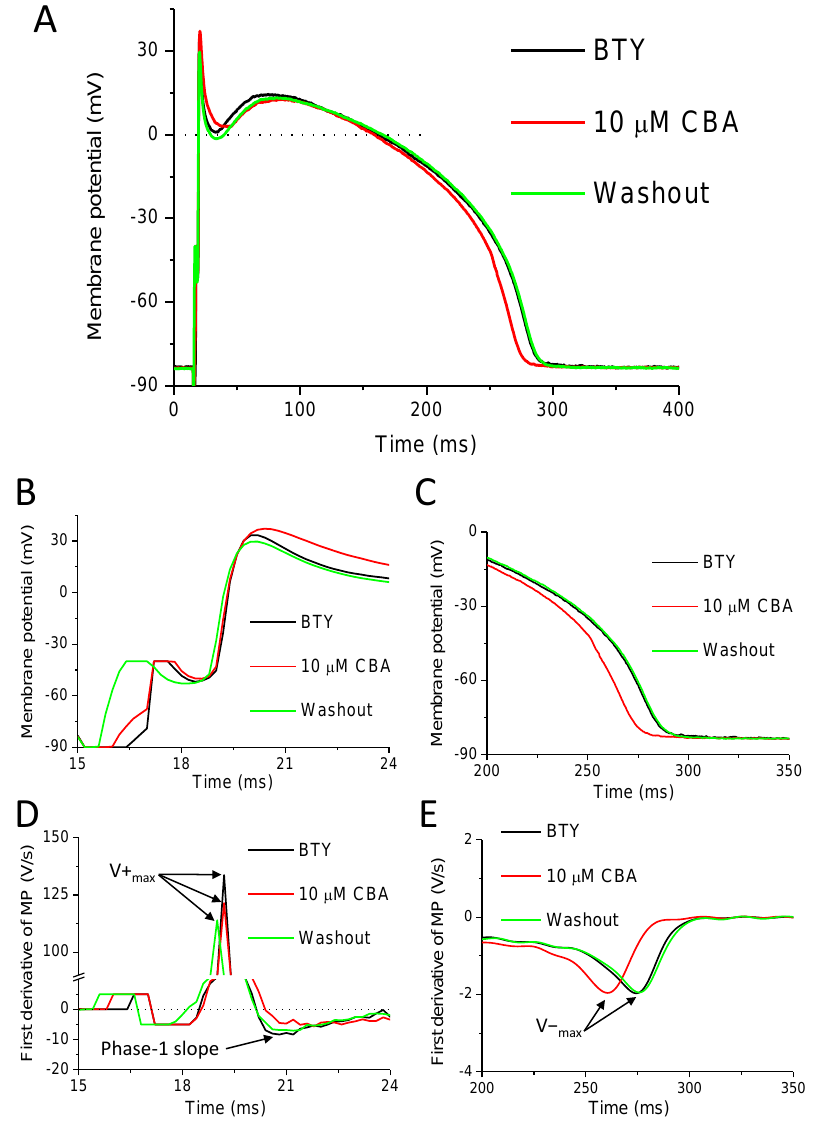
Figure 2. Effect of CBA on action potentials (APs) of canine left ventricular cells. ( A ) Representative APs recorded in control conditions (black), in the presence of the TRPM4 inhibitor (4-chloro-2-(2-chlorophenoxy)acetamido)benzoic acid (CBA), (10 µ M) (red) and after washout of CBA (green). ( B ) The initial part of the APs is shown enlarged. ( C ) The terminal repolarization of the APs is shown enlarged. ( D ) The first derivative of curves on panel B illustrating the maximal rates of depolarization (V + max ) and early repolarization (phase-1 slope). ( E ) The first derivative of curves on panel C illustrating the maximal rate of late repolarization (V − max ). Stimulus artefacts and corresponding signal parts on panels ( B , D ) were removed for better visibility and the curves of panel ( E ) were Table 1. Unaltered AP parameters by CBA recorded from eight individual cells obtained from six animals.